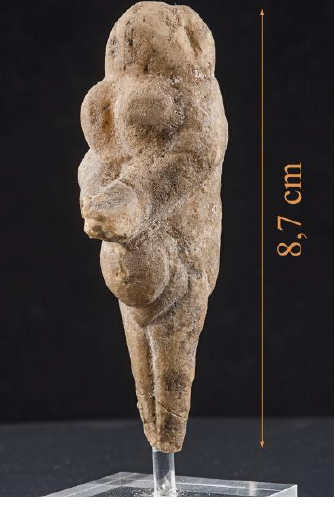
Figure 5. The Venus of Frasassi (8,7 cm)